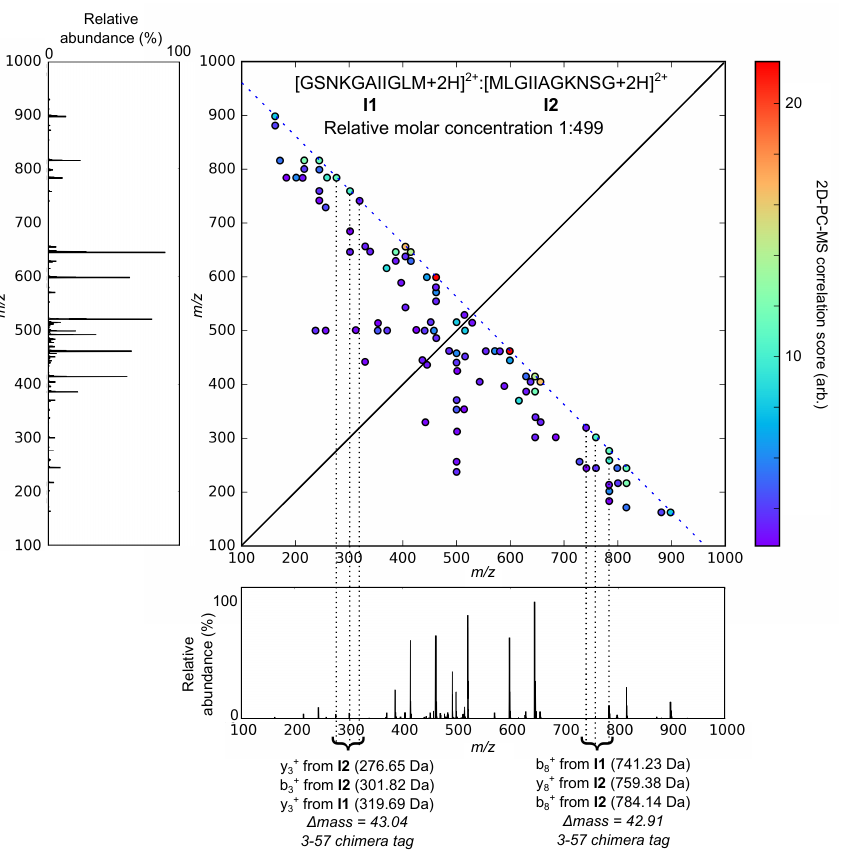
Figure 2. 2D-PC-MS map of the chimera spectrum of a mixture of [GSNKGAIIGLM + 2H] 2+ ( I1 2+ ) and [MLGIIAGKNSG + 2H] 2+ ( I2 2+ ) at a relative molar concentration of 1:499. The standard 1D tandem mass spectrum of the mixture is appended to the x- and y-axes for visual clarity. The autocor- relation diagonal of the 2D-PC-MS map, with respect to which it is symmetric, is shown by a full line. The autocorrelation signals of each and every fragment with itself are removed for clarity. The single primary mass conservation line, characteristic of doubly charged peptides (see Equation (4)), is shown by the blue dashed line. Fragment-fragment correlations are shown by circles, color-coded according to the values of their 2D-PC-MS correlation scores, Equation (3). 2D-PC-MS correlations of the complementary fragment ions are located on the primary mass conservation line. Two groups of three such correlations are found to lie within ∆ mass < 57 Da mass range, representing the two 3-57 chimera tags, shown by the vertical dotted lines. The identities of the complementary fragments forming the chimera tag correlations are also shown, although assignment of the complementary ions is not necessary for the 3-57 chimera tag identification; see text for